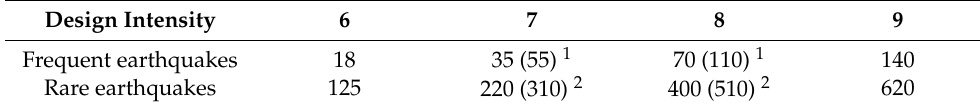
Table 2. Maximum value of input seismic acceleration for time-history analysis (cm/s 2 ).